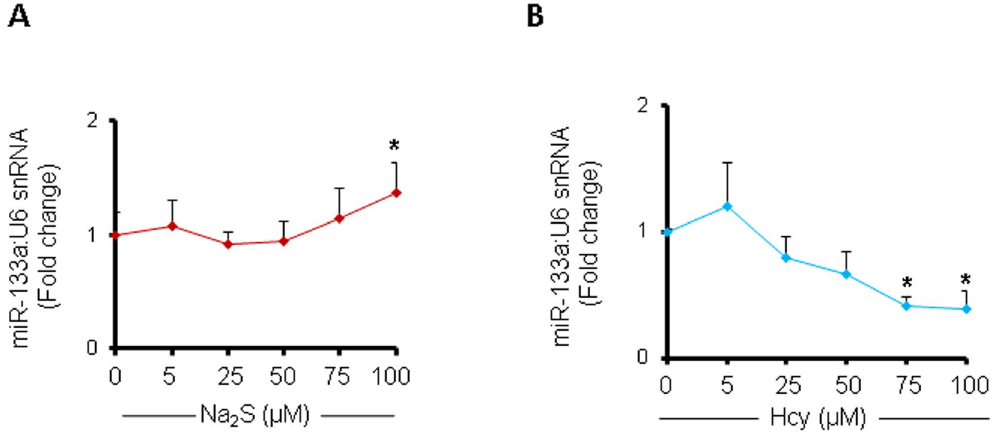
Figure 4. Dose-dependent effect of Na 2 S or Hcy on miR-133a levels in HL1 cardiomyocytes. ( A ) Individual miR-133a assay showing the dose-dependent effect of Na 2 S or ( B ) Hcy on miR-133a levels in cardiomyocytes. U6 is an endogenous control. Values are represented as mean ± SEM. “ * ” represents significant value when compared to the untreated control. p < 0.05 is considered statistically significant. N =